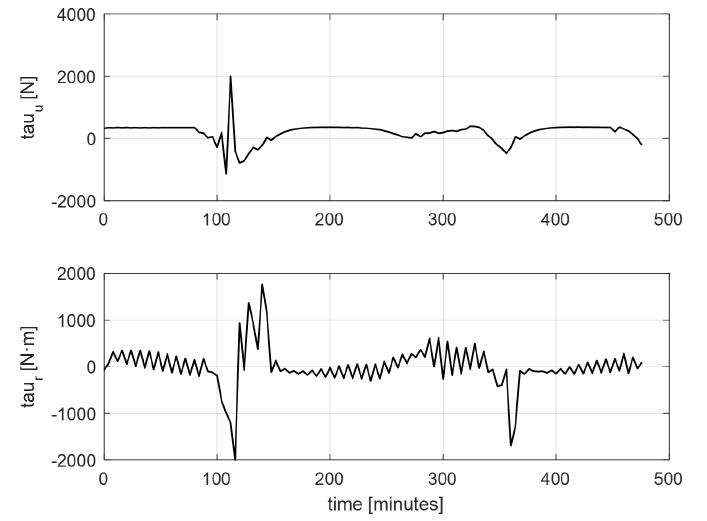
Figure 18. Variability of control in RHNC system with collision avoidance and event